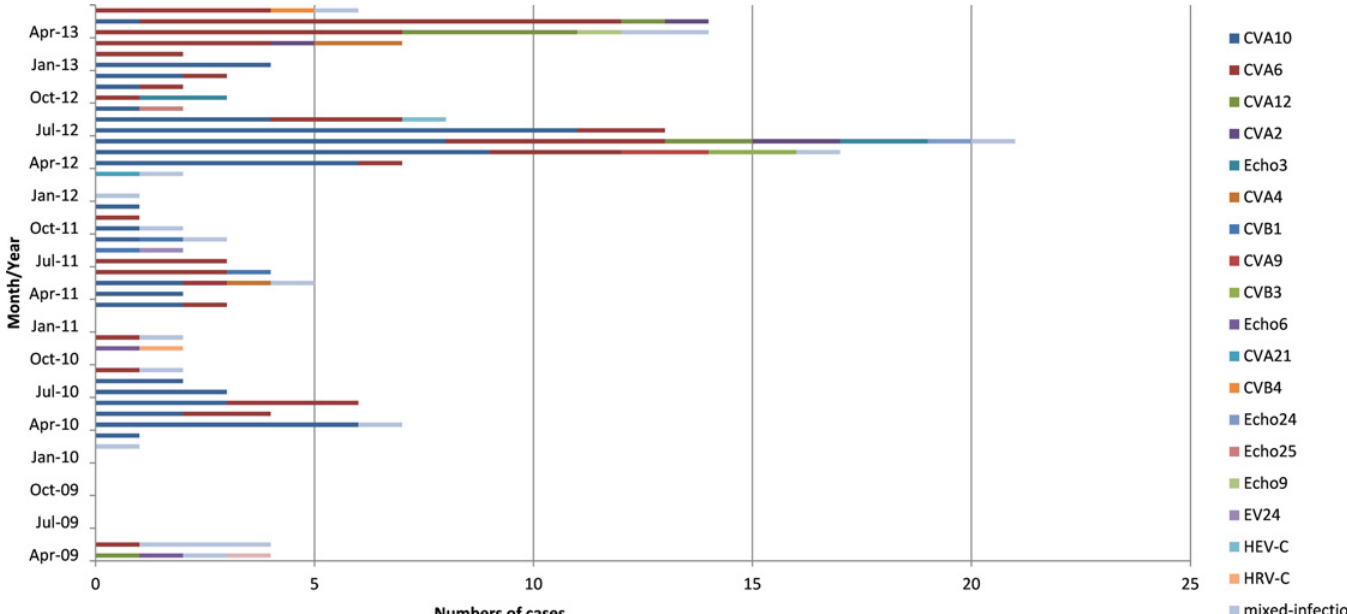
Fig 2. Monthly distribution of non-EV71 and non-CVA16 enterovirus serotypes during 2009 to June 2013 in Jinan, China.